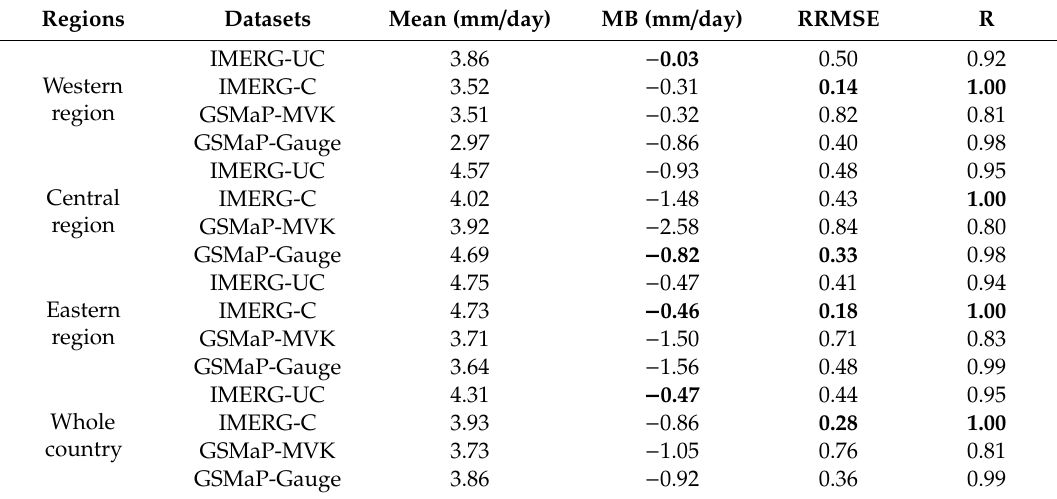
Table 3. Statistical metrics in the western, central, and eastern regions, as well as in the whole study region, derived from the regional monthly mean precipitation (mm / day) from 2015 to 2016. Bold font indicates the best performance for a given